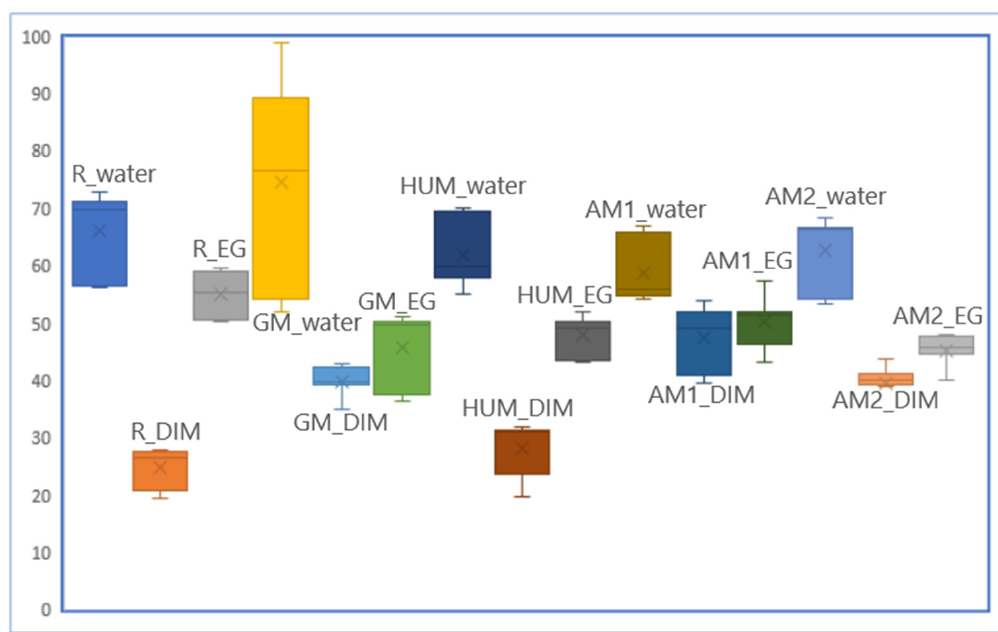
Figure 3. Surface wettability of the investigated bone cement samples determined by the measurements of the contact angle with distilled water, DIM, and EG.